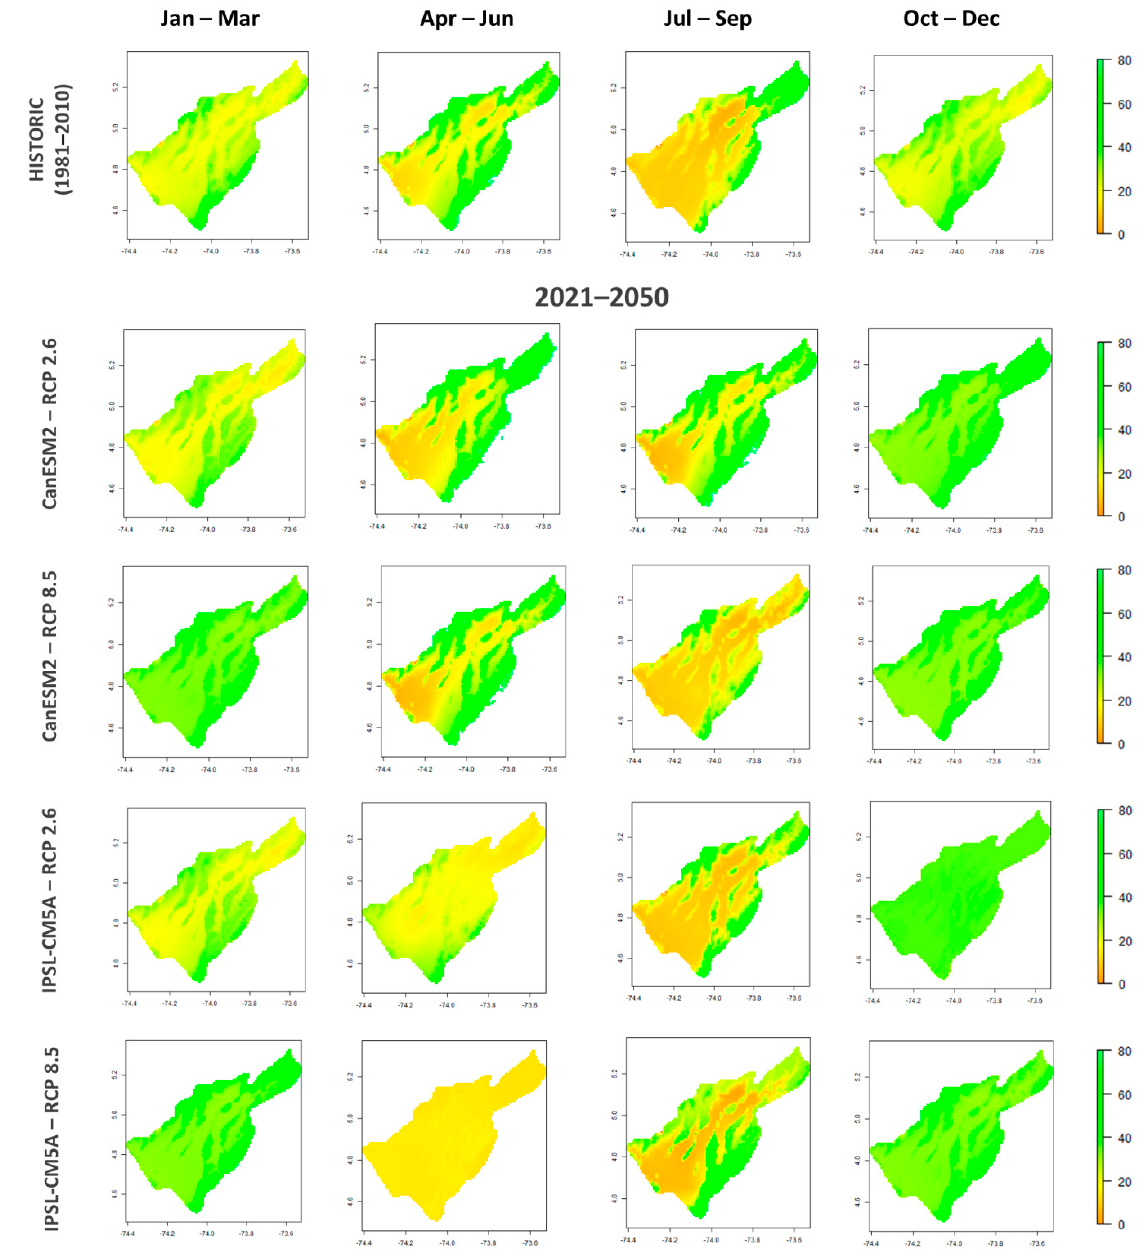
Figure B5. Stream Flow 2021–2050 Figure A9. Stream Flow